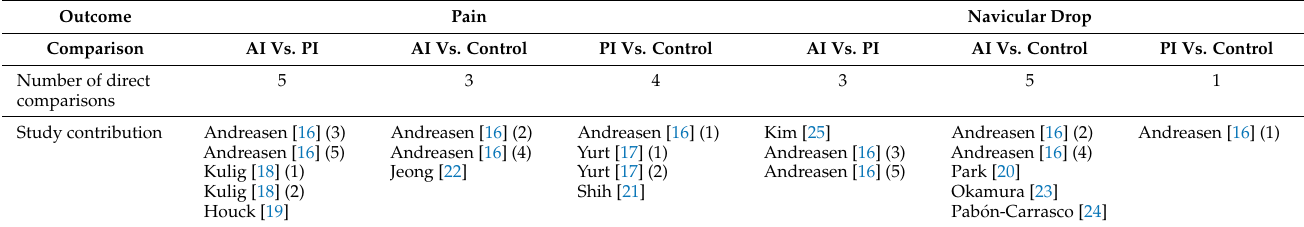
Table 5. Contributions of each study in each